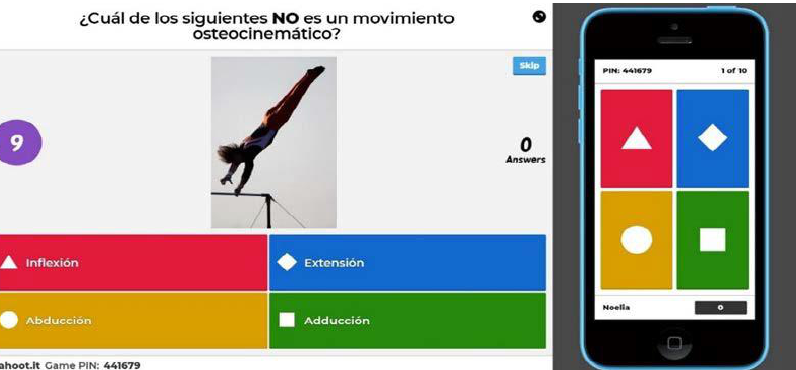
Figure 1. Kahoot! Test projected in class (left) and appearance of the student’s smartphone (right) during the period given to select the correct answers. Image obtained from a self-made questionnaire on the Kahoot! platform.